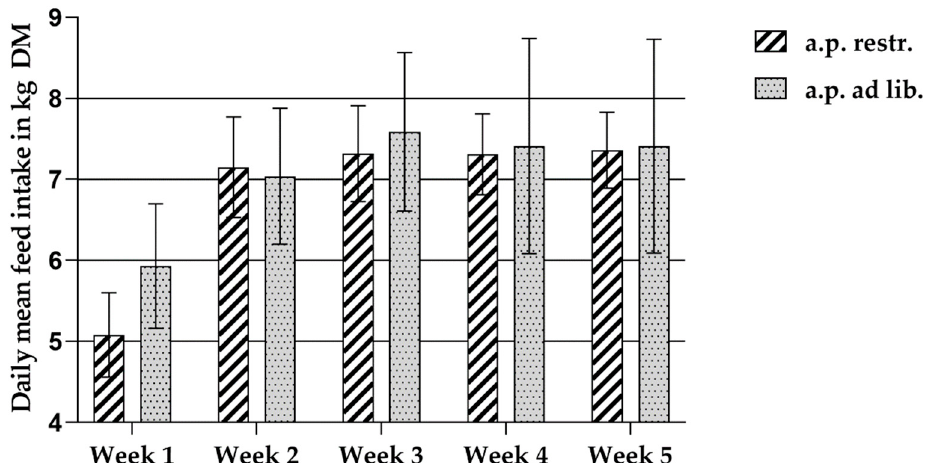
Figure 2. Mean values of the daily mean feed intake in kg DM during the lactation weeks separated by feeding groups (ante partum (a.p.) restrictively fed sows: n = 17; a.p. ad libitum-fed sows: n = 23 (FG-1, 2)).